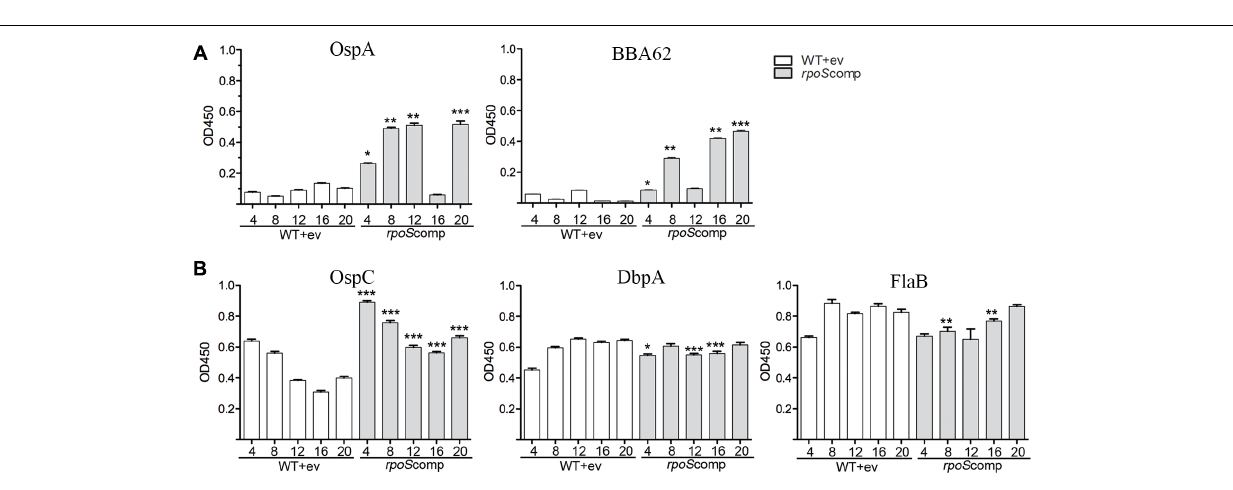
FIGURE 6 | Loss of the rpoS -complementing plasmid by (cid:49) rpoS B. burgdorferi is associated with production of antibodies against OspA and BBA62 in mice. ELISA assay performed using sera collected from individual C3H/HeJ mice and purified recombinant proteins for tick-phase gene products (OspA and BBA62) repressed by RpoS in mammals (A) and genes products upregulated (OspC and DbpA) or unaffected (FlaB) by RpoS (B) . Sera was collected at the designated time points (in weeks) following syringe-inoculation with either WT+empty vector (BbP1974) or rpoS comp (BbP1754). Columns represent the average and standard error of the mean from three mice per strain, per time point (4- to 20-weeks). p -Values for pairwise comparisons (WT vs. rpoS comp) were determined using a two-tailed t -test. ∗ p ≤ 0.05; ∗∗ p ≤ 0.001; ∗∗∗ p ≤